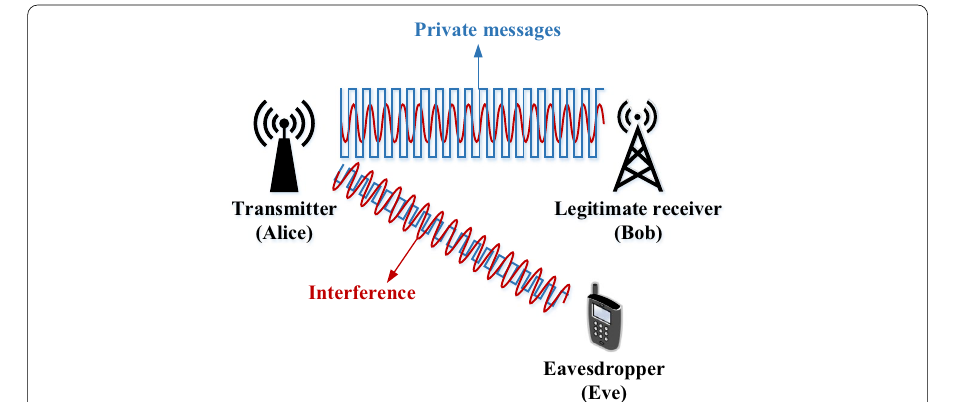
Fig. 1 A three-node wireless wiretap system model